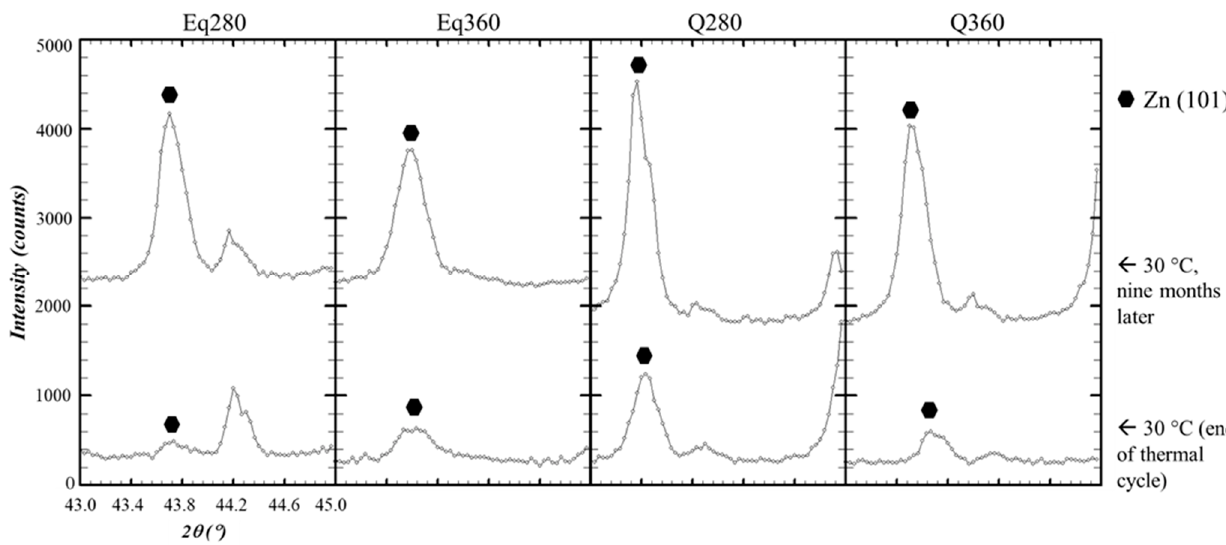
Figure 10. Close-up of the diffraction patterns of samples Eq280, Eq360, Q280, and Q360 showing the Bragg peaks of the (101) plane of the Zn phase. At the bottom, we show the profiles of the last measurements in the thermo-diffractometer at 30 °C at the end of the cooling cycle. At the top, we show the profiles obtained at the same temperature nine months later.